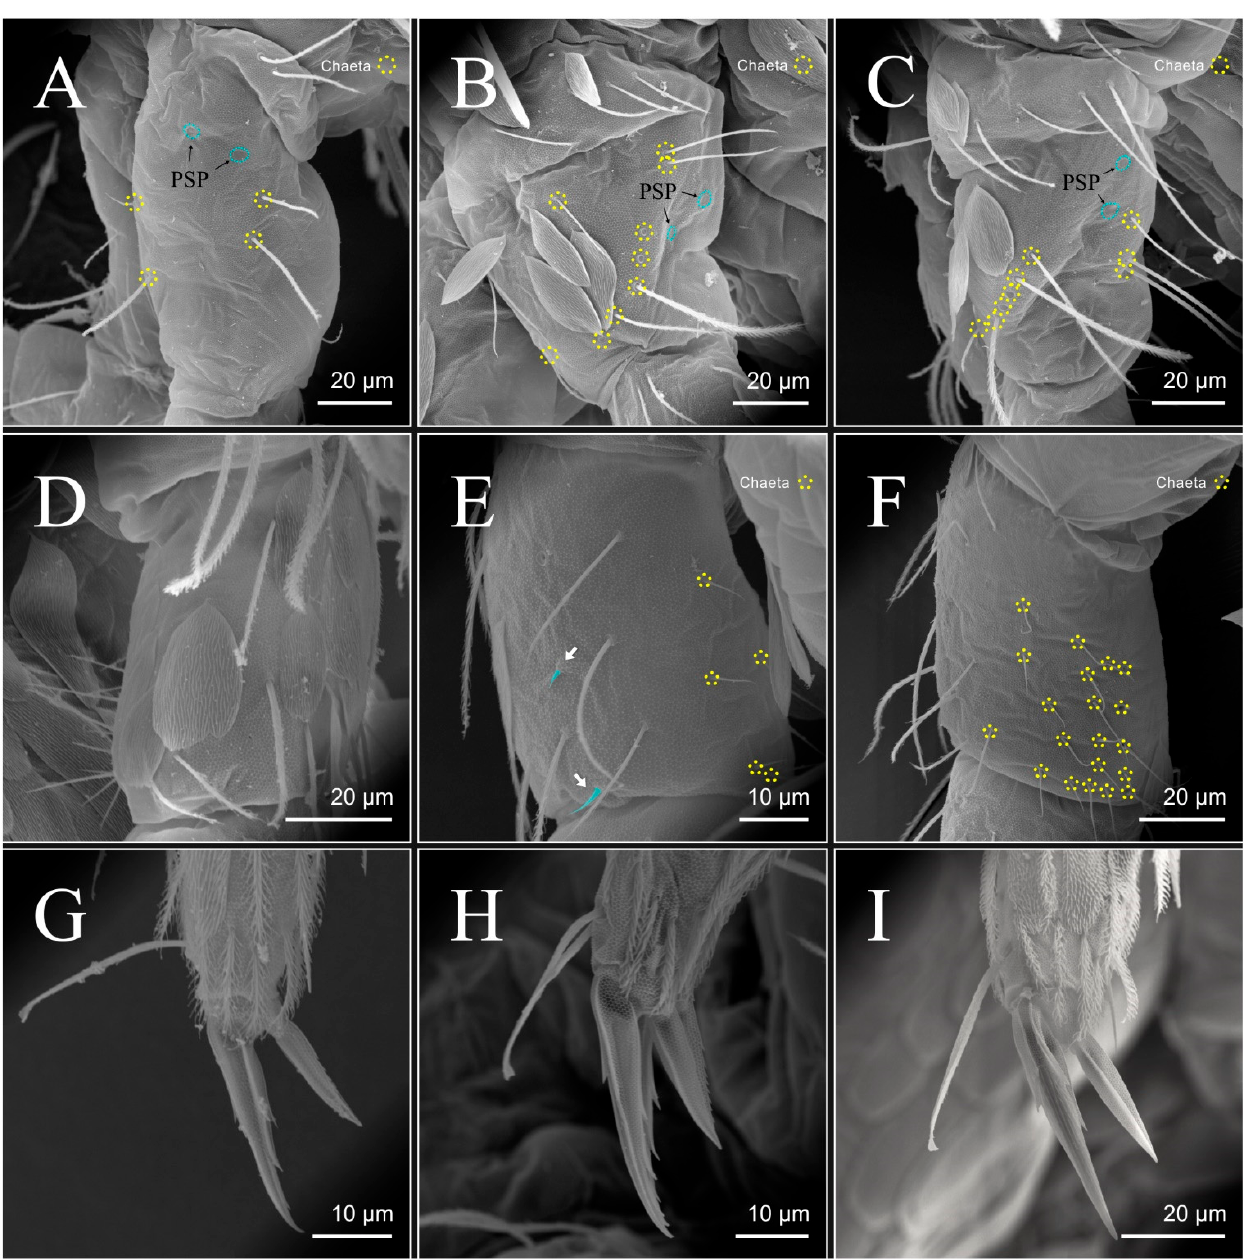
Figure 12. Seira musarum SEM: Legs: ( A – C ), subcoxa I, II and III; ( D – F ), metatrocater; ( G – I ), claws I, II and III.